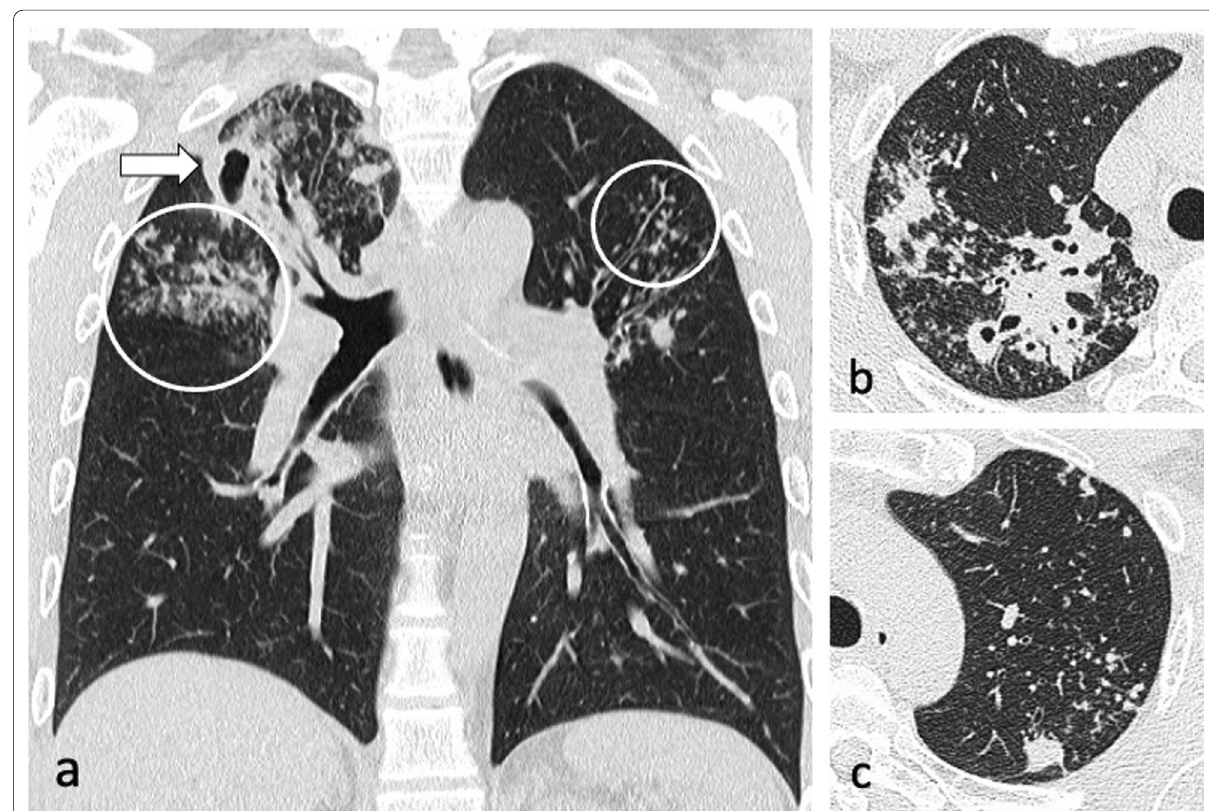
Fig. 3 A 41-year-old male presented with chronic cough, weight loss and fevers. CT (lung window) demonstrates bilateral areas of centrilobular and tree-in-bud nodules (coronal plane— a , circled; axial plane— c ) and consolidation in the right upper lobe (axial plane— b ). There are also cavitating lesions with thick walls (arrow, a